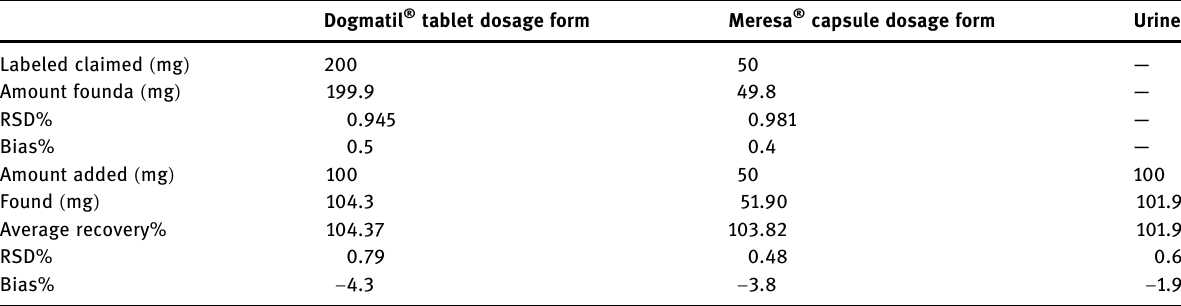
Table 4: Recovery results achieved from the detection of SUL in urine and pharmaceutical dosage forms